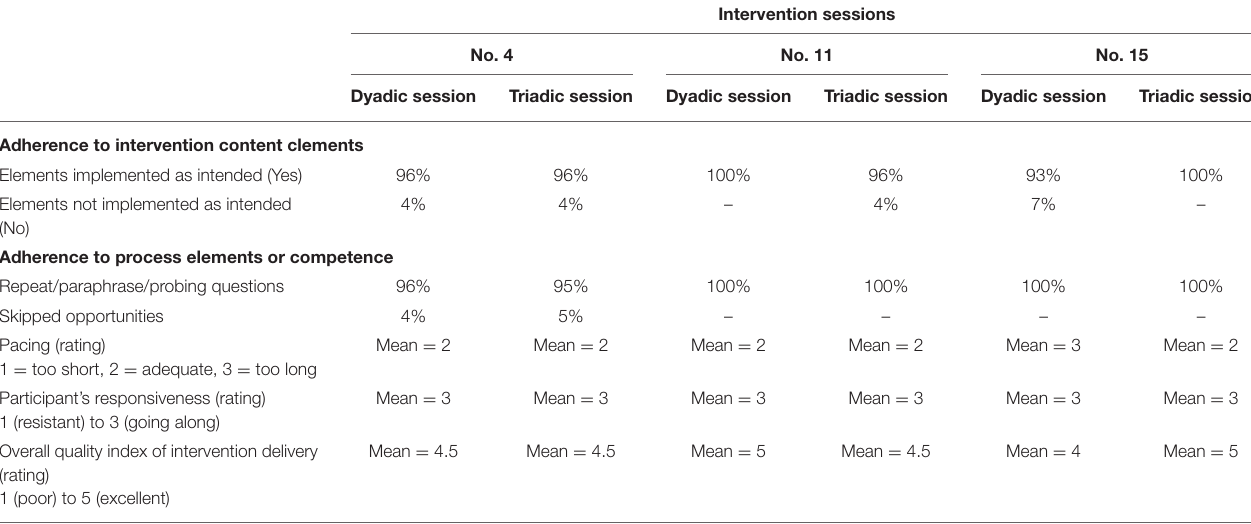
TABLE 5 | Evaluation of 6 sessions from 3 participants using the ATTACH TM fidelity checklist.